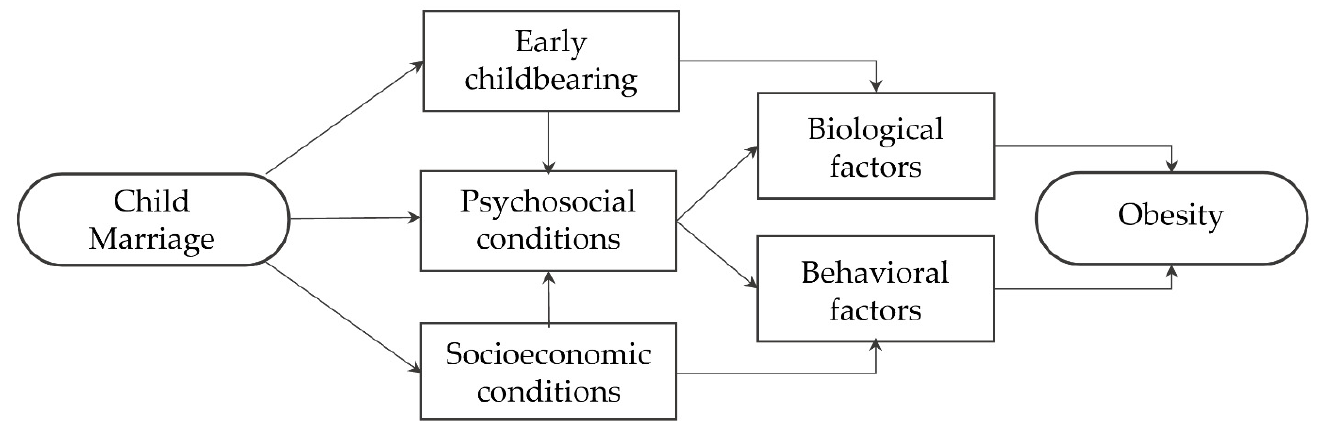
Figure 1. Conceptual framework of the relationship between child marriage and obesity.